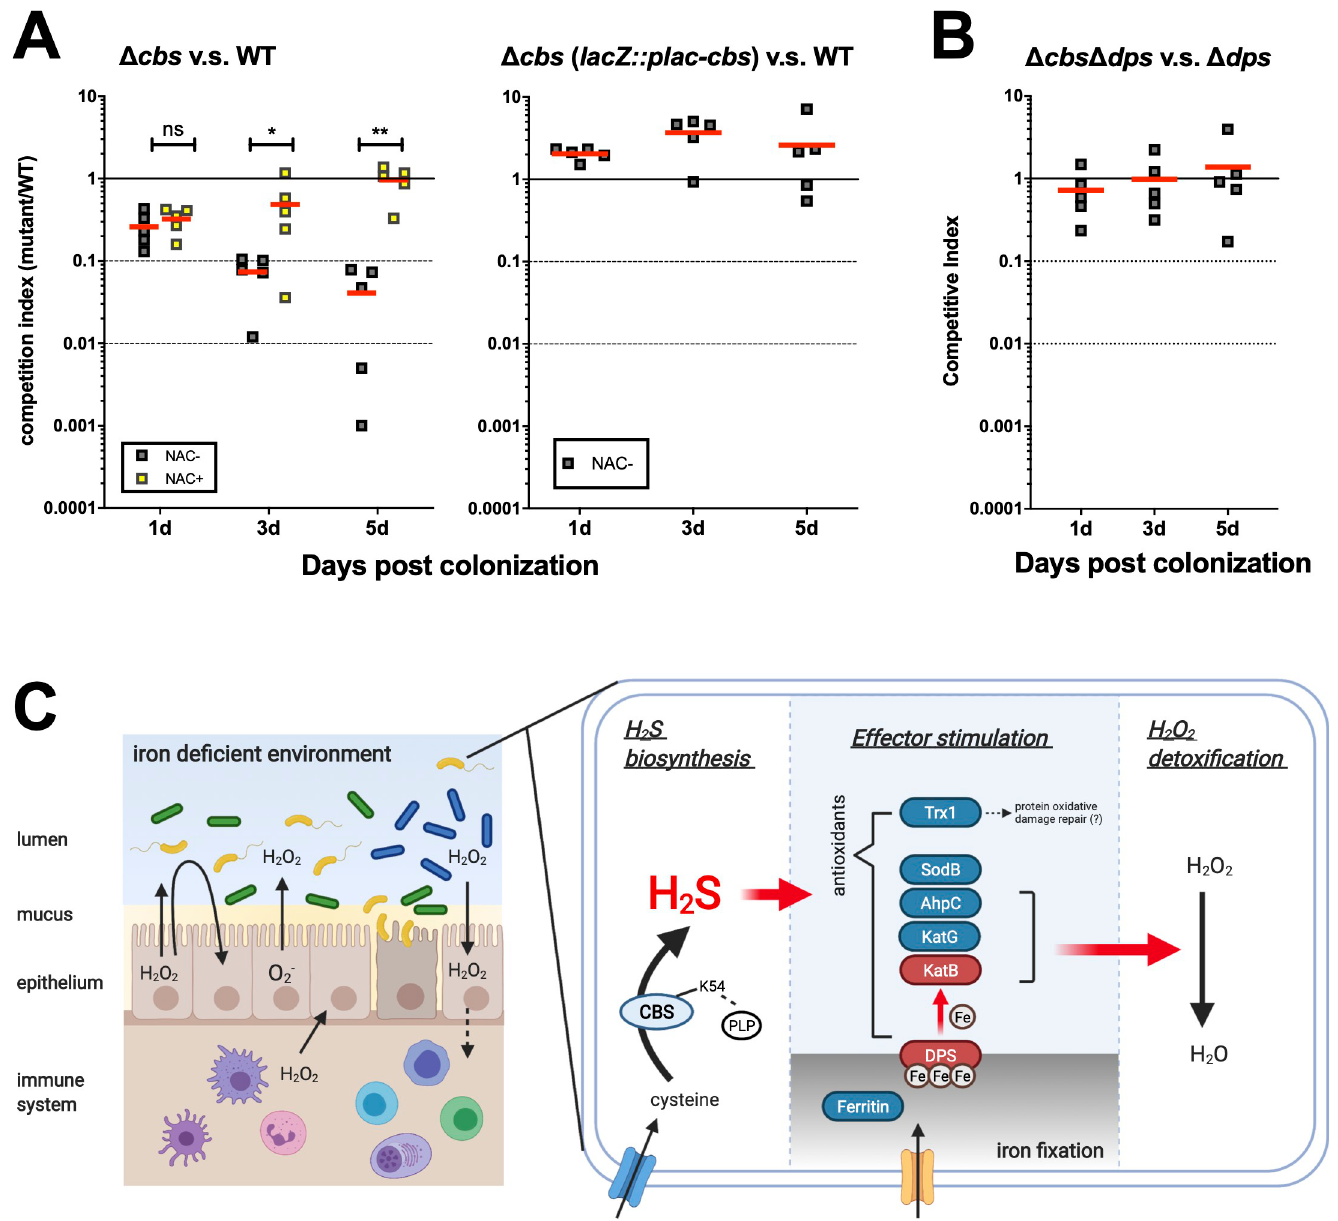
Fig 6. CBS-derived H 2 S promotes the fitness of V . cholerae in adult mouse via fighting against oxidative stress. (A). Adult CD1 mice were treated, without or with 1% N-acetyl cysteine (NAC), in drinking water for 7 days, then administrated with wild-type (WT) and either Δ cbs or Δ cbs complemented by single copy P lac -cbs ( Δ cbs lacZ :: P lac -cbs ) mutants after streptomycin treatment. Fecal pellets were collected at 1, 3, and 5 days post inoculation. Bacterial loads were quantified by plating. Competition index (CI) was calculated as the ratio of mutant to wild-type colonies normalized with the input ratio. Red line indicated for the average CI. Significance was determined by t -test; p -value: ns, not significant, � , < 0.05, �� , < 0.01. (B). Streptomycin-treated adult CD1 mice were administrated with Δ dps and Δ cbs Δ dps . Fecal pellets were collected at 1, 3, and 5 days post inoculation. Bacterial loads were quantified by plating. Competition index (CI) was calculated as the ratio of Δ cbs Δ dps to Δ dps colonies normalized with the input ratio. Red line indicated for the average CI. (C). A proposed mechanism for the cytoprotective effects of CBS-derived H 2 S against oxidative stress in V . cholerae . Iron availability is limited for V . cholerae during infection of host. The cbs -dependent generation of H 2 S from cysteine stimulates the expression of several antioxidants and facilitates the acquisition and storage of iron in V . cholerae . Enriched intracellular iron pool promotes the activity of heme- catalase KatB, by contributing to the assembly of active catalases. The illustration is created with BioRender.com.